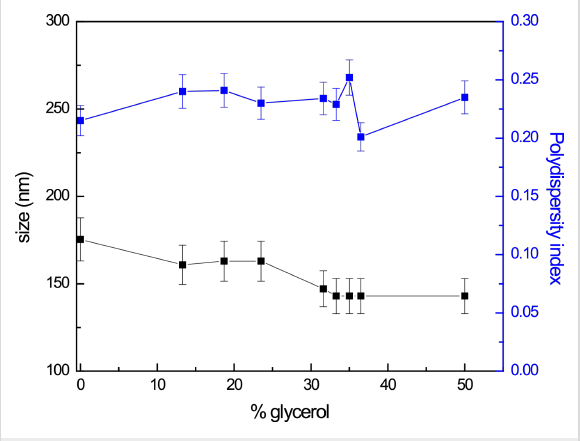
Figure 4: Variation of diameter and polydispersity index of SH–DOPC LUVs with glycerol content.